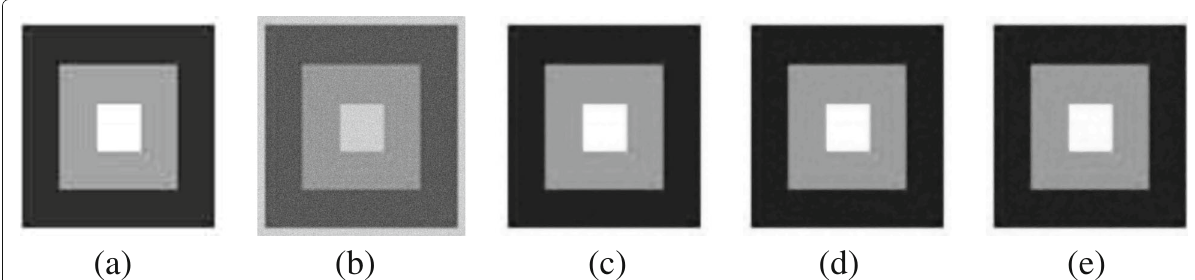
Fig. 14 Recovered results on SynImage1 a original image; b SynImage1 image corrupted with Gaussian noise with σ = 18; c denoised image by optimal value of c = 1.76; d denoised image by c = 1.84; e denoised image by c = 1.68